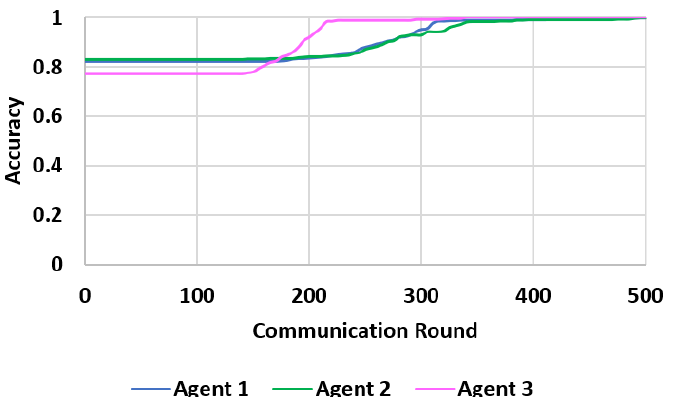
Figure 18. FedResilience’s impact on participating FL agents’ (three agents and two stragglers) model accuracy for the prediction of CIAs’ resource-sharing